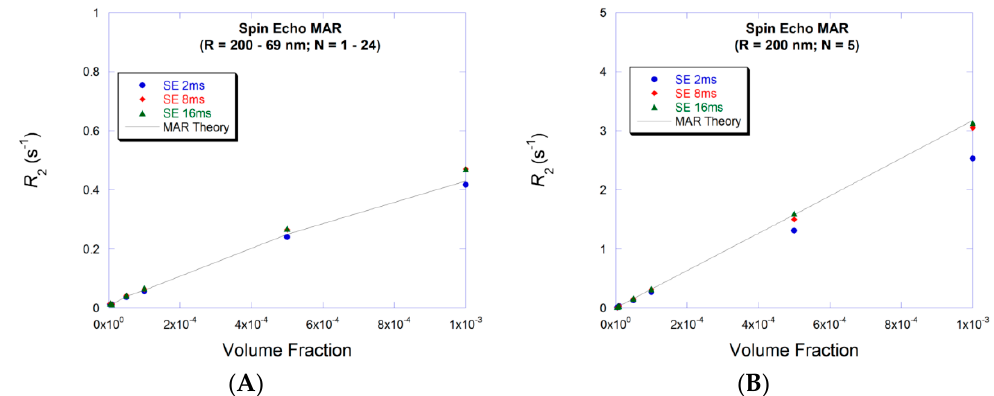
Figure 3. R 2 values are plotted vs. particle volume fraction for particles within MAR. ( A ) The particle size is increased while the radius is decreased to achieve increasing volume fraction; ( B ) The particle size and radius are kept constant while the sample space is decreased to achieve increasing volume fraction. R 2 is also equal to R 2 * shown in Figure 2.